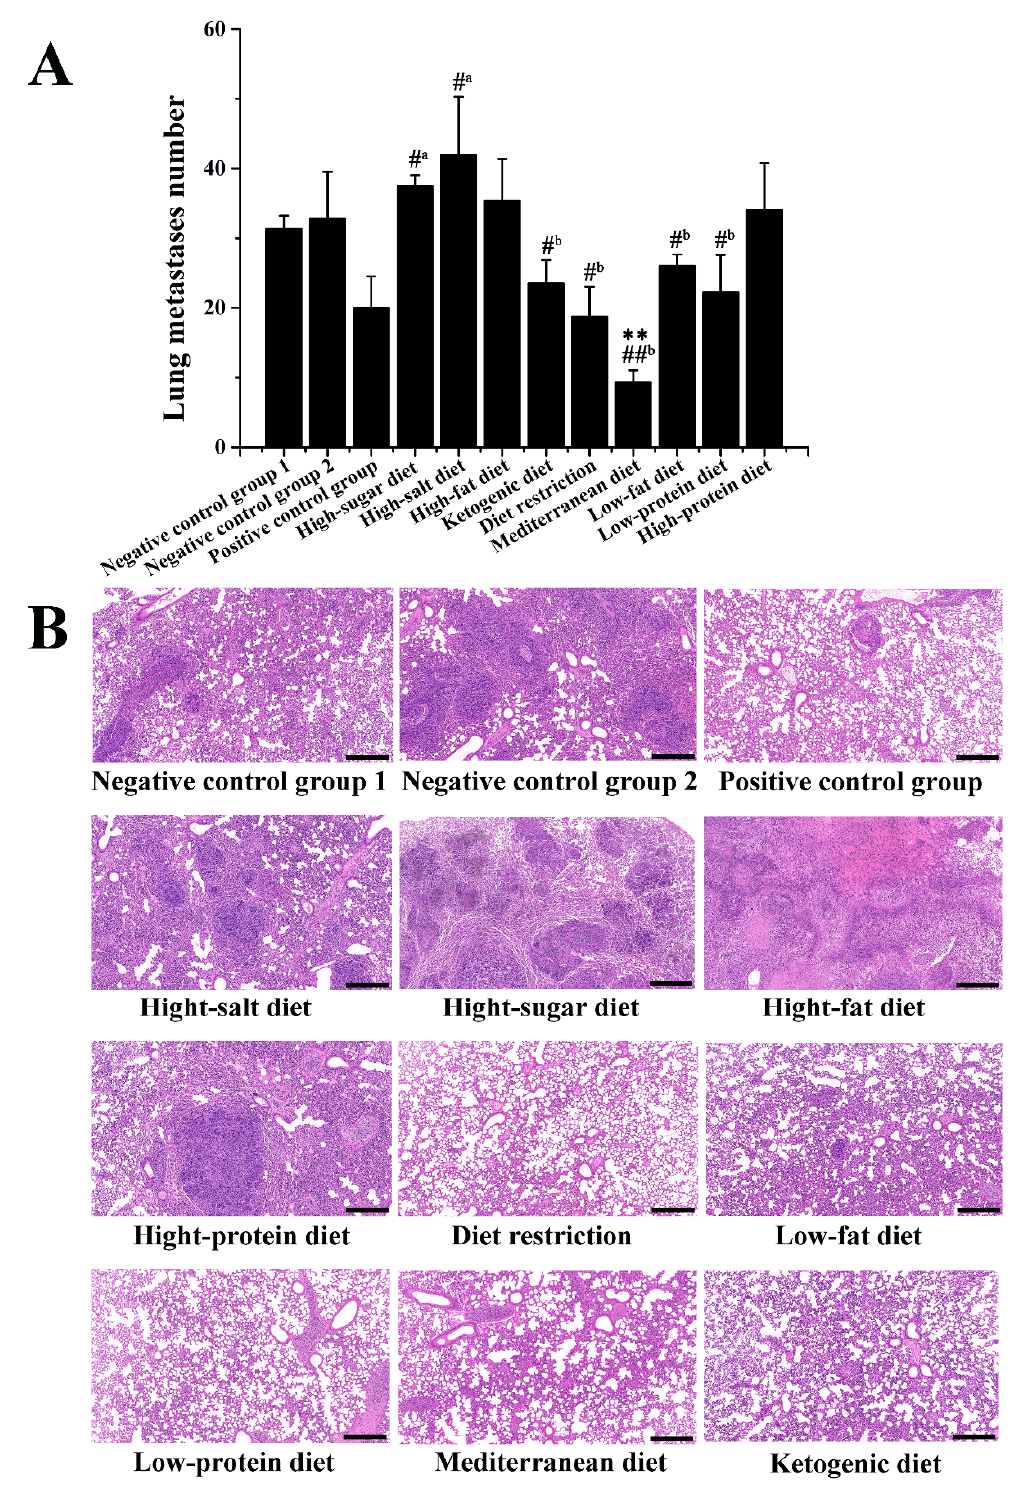
Figure 3. Effects of different dietary patterns on lung metastasis of 4T1-xenograft mice. ( A ) Number of lung metastasis. #a of lung metastasis. #a p < 0.05 compared with that of negative control group 1. #b p < 0.05 and p < 0.05 compared with that of negative control group 1. #b p < 0.05 and ##b p < 0.01 compared with that of negative control ##b p < 0.01 compared with that of negative control group 2. ** p < 0.01 compared with that of positive group 2. ** p < 0.01 compared with that of positive control group. ( B ) HE-staining of lung tissues (scale was 400 μ m). control group. ( B ) HE-staining of lung tissues (scale was 400 µ